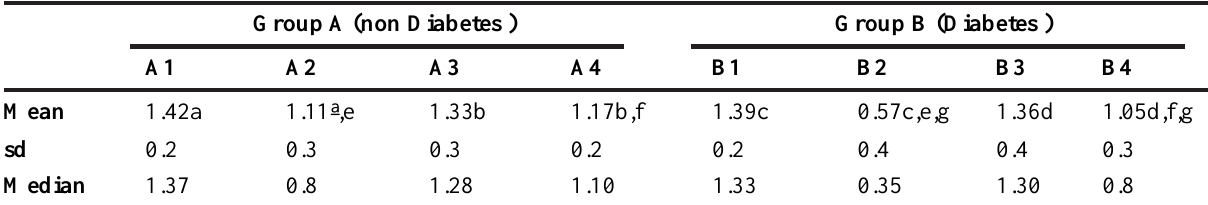
TABLE 2 - Distribution of means (sd) and median of the ratio of measures of Bowman capsule and glomerulus diameters (µm) in the groups of diabetics and non diabetics rats with one or two ESW Group A (non Diabetes